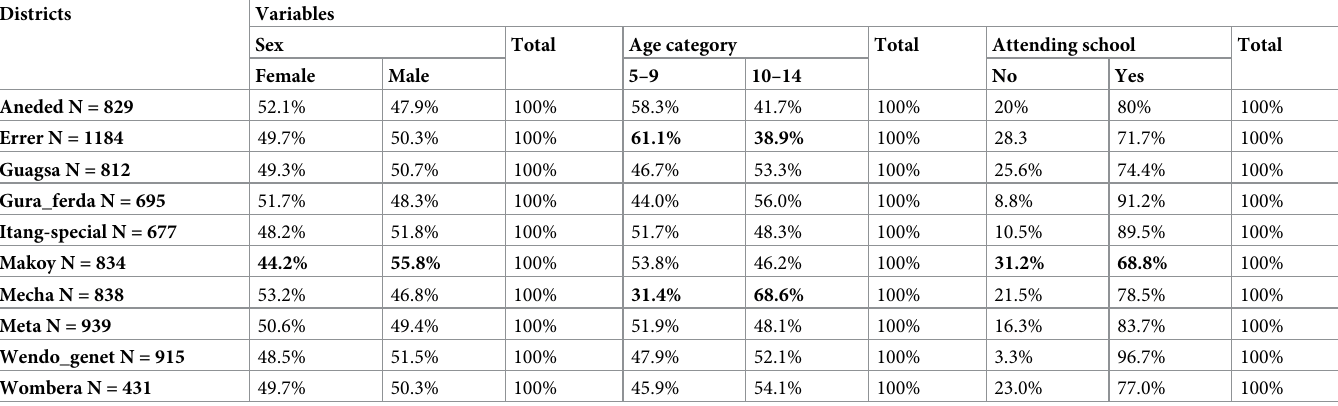
Table 1. Proportion of interviewed SAC dis-aggregated by sex, age and school attendance in ten districts of Ethiopia, 2019.